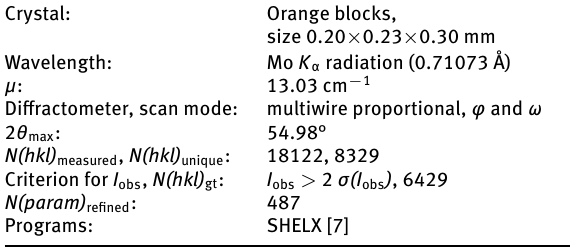
Table 1: Data collection and handling.